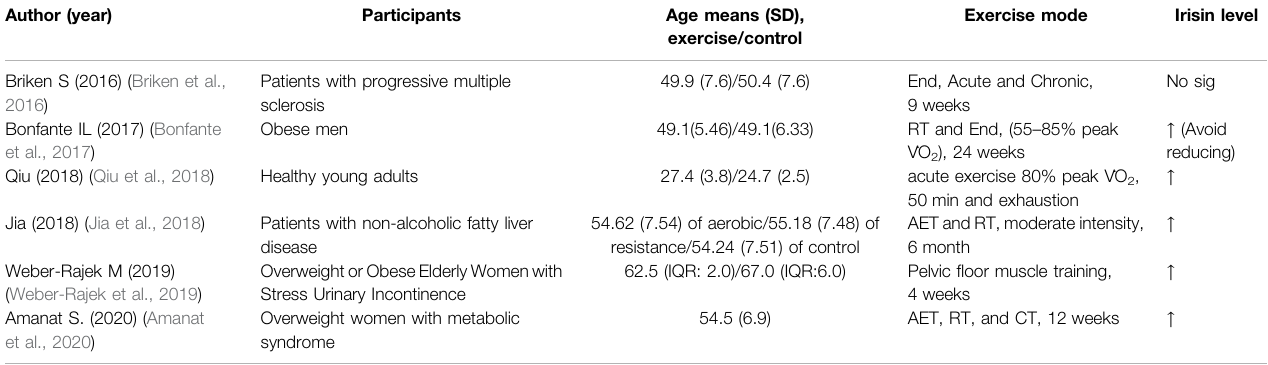
TABLE 2 | Characteristics of randomized-controlled trials that explored the effects of exercise on circulating irisin concentrations in